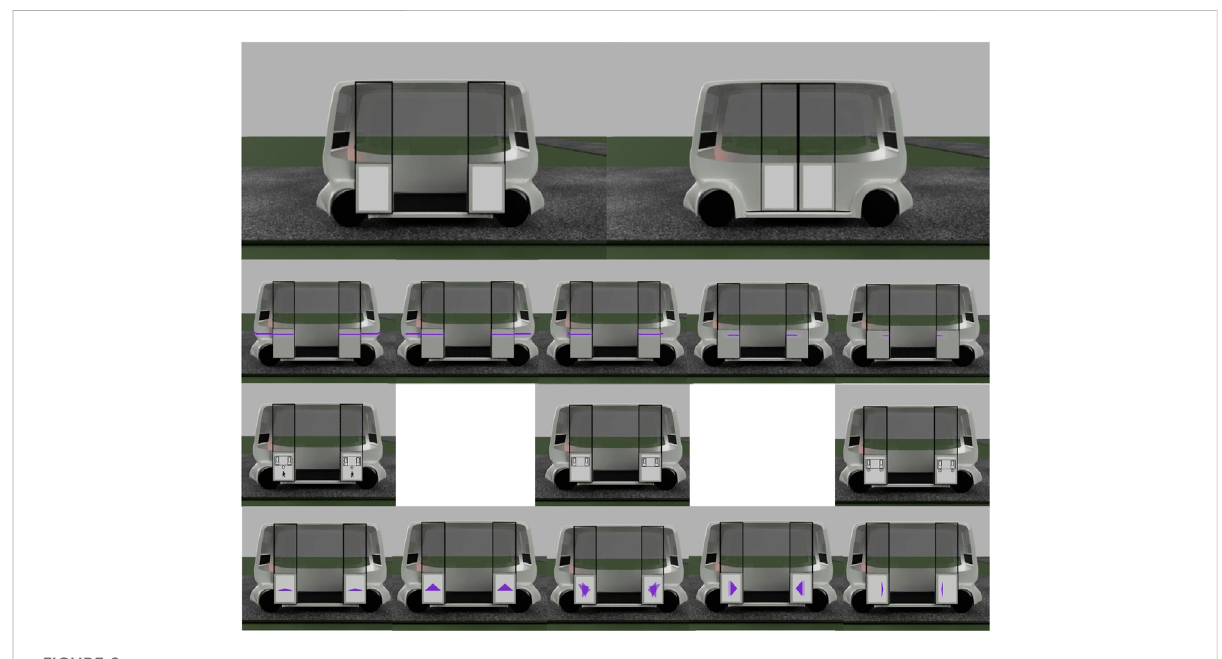
FIGURE 2 Boarding — overview of all initial